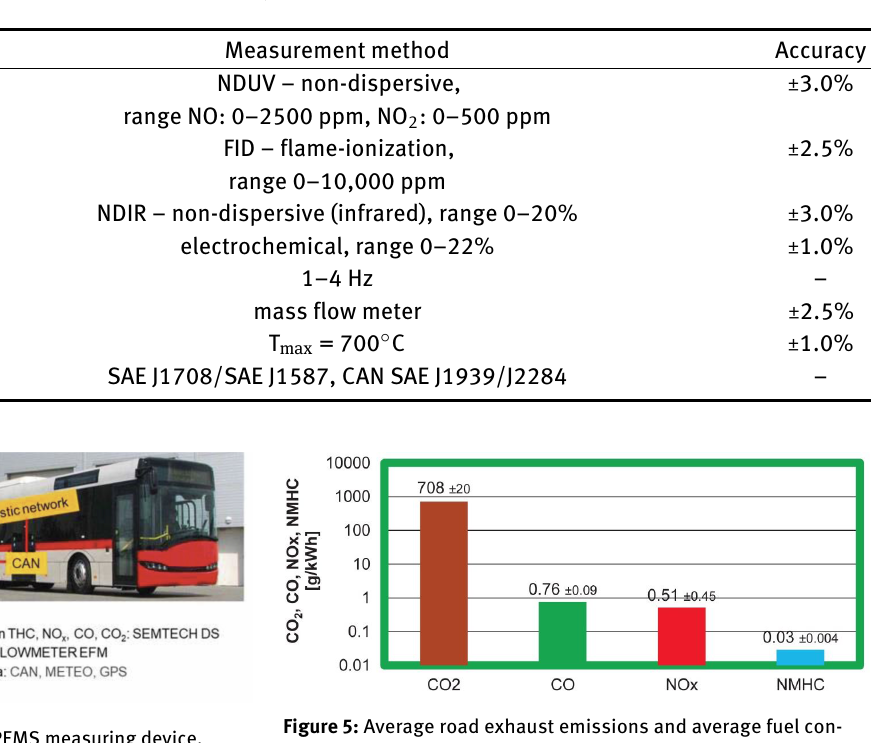
Figure 4: Technical parameters of the PEMS measuring device.